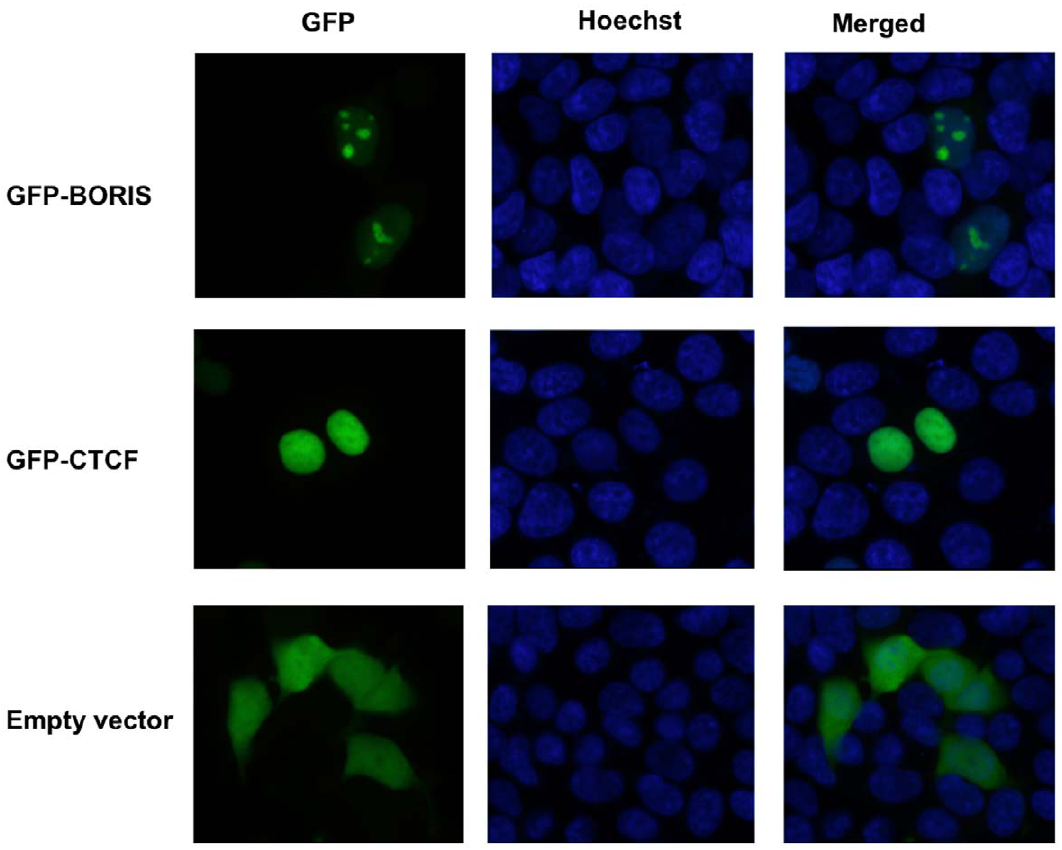
Figure 6. Transfection of BORIS confirms enrichment in the nucleolus. Live cell imaging of HEK293T cells transiently transfected with GFP- tagged BORIS (green), GFP-tagged CTCF (green) or empty vector (green), counterstained with Hoechst 333412 (blue). Images are shown at 40x magnification.